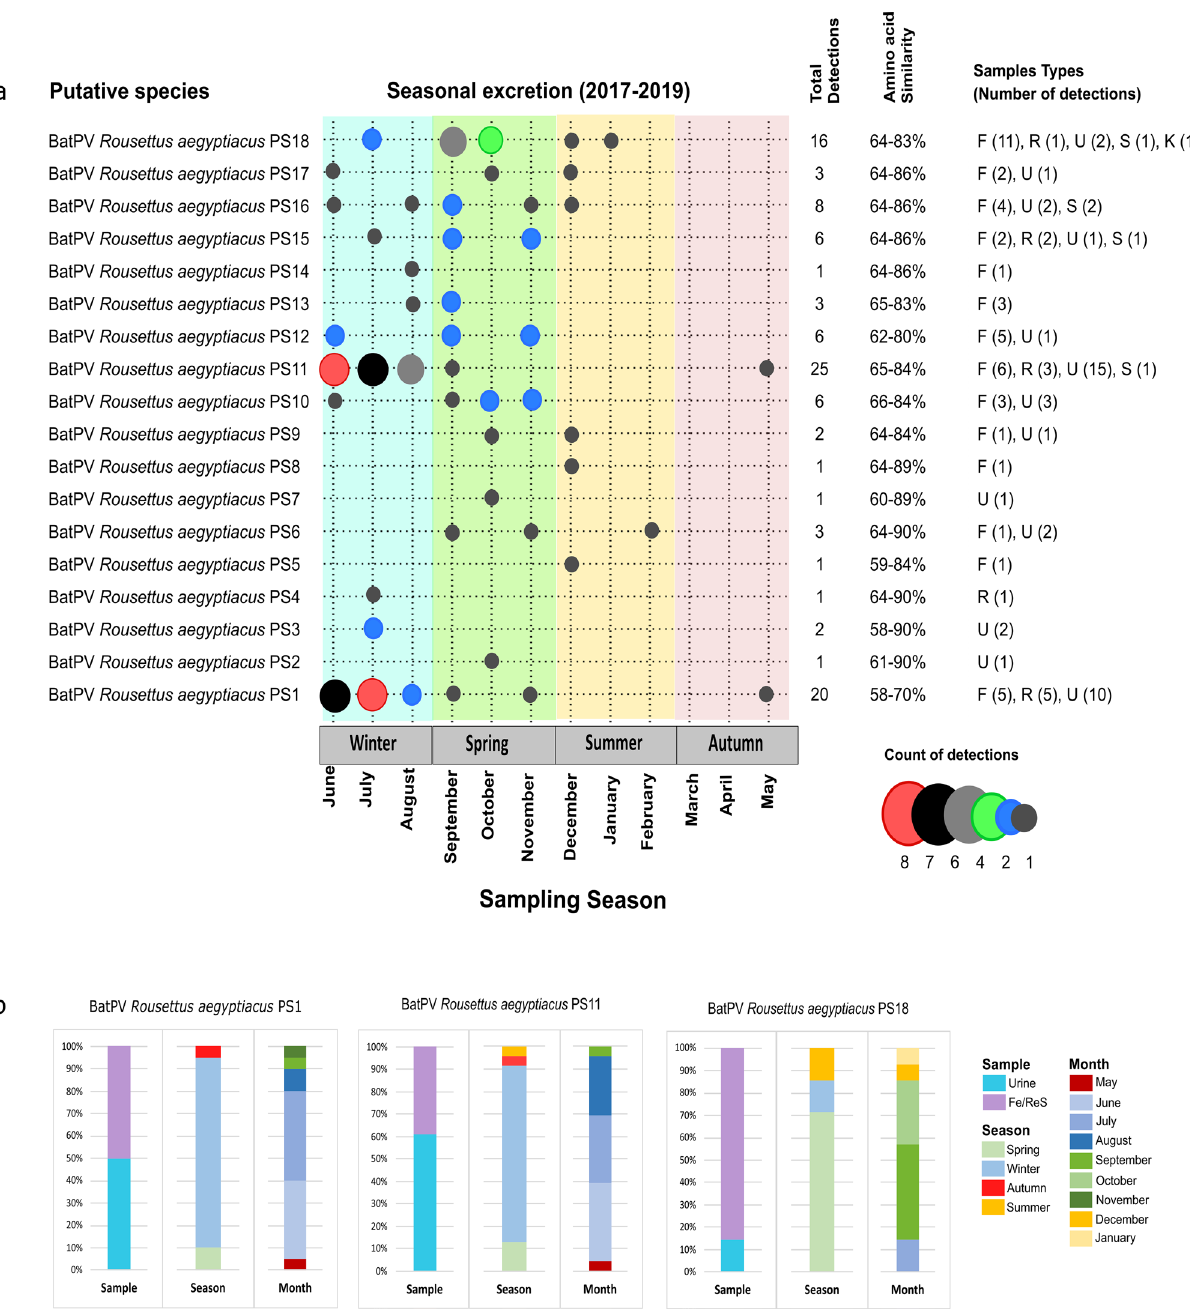
different color bars per season (sampling period June 2017 to September 2019). The number of detections is represented by dots of different sizes and colors. The total number of detections represents both the initial tissue-based biosurveillance and longitudinal excretion data. Amino acid similarities were based on a 150 amino acid sequence and indicate the similarity shared between the putative species. Sample types are F—fecal, R—rectal swabs, U—urine, S—spleen, and K—kidney. b. Bar charts represent the proportion of RNA-positive samples for putative species (PS) 1 (n = 20), PS11 (n = 23), and PS18 (n = 14) detected in bat excreta specific to sample type, season, and month of detection. For sample type, detections for fecal (Fe) and rectal swabs (ReS) were combined, as they form part of the same excretion